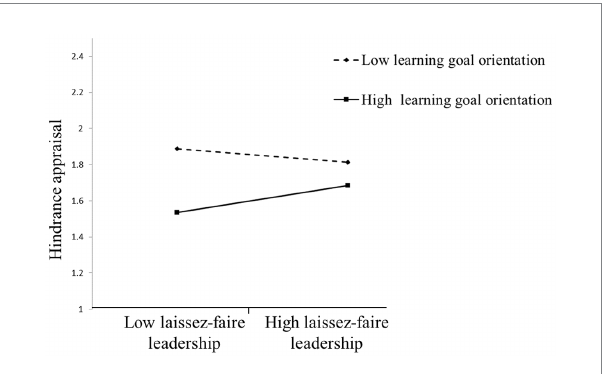
FIGURE 2 Learning goal orientation moderates the relationship between laissez-faire leadership and hindrance appraisal.